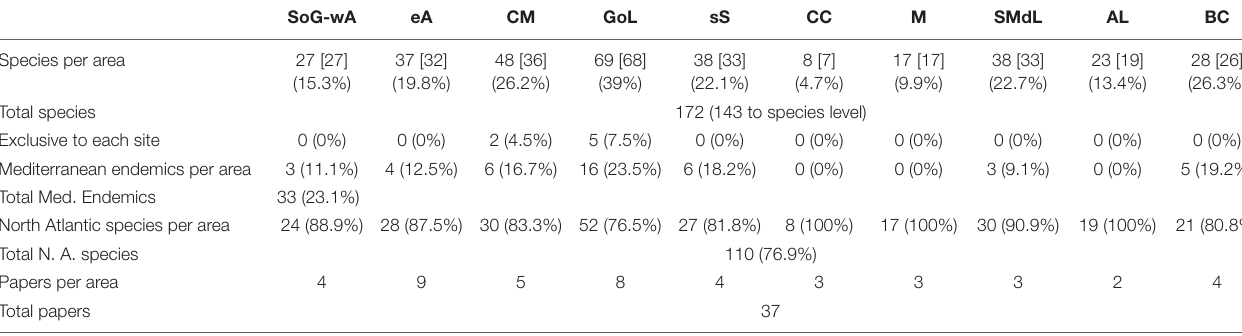
TABLE 7 | Comparative table between all the analyzed CWC provinces. SoG-wA eA CM GoL sS CC